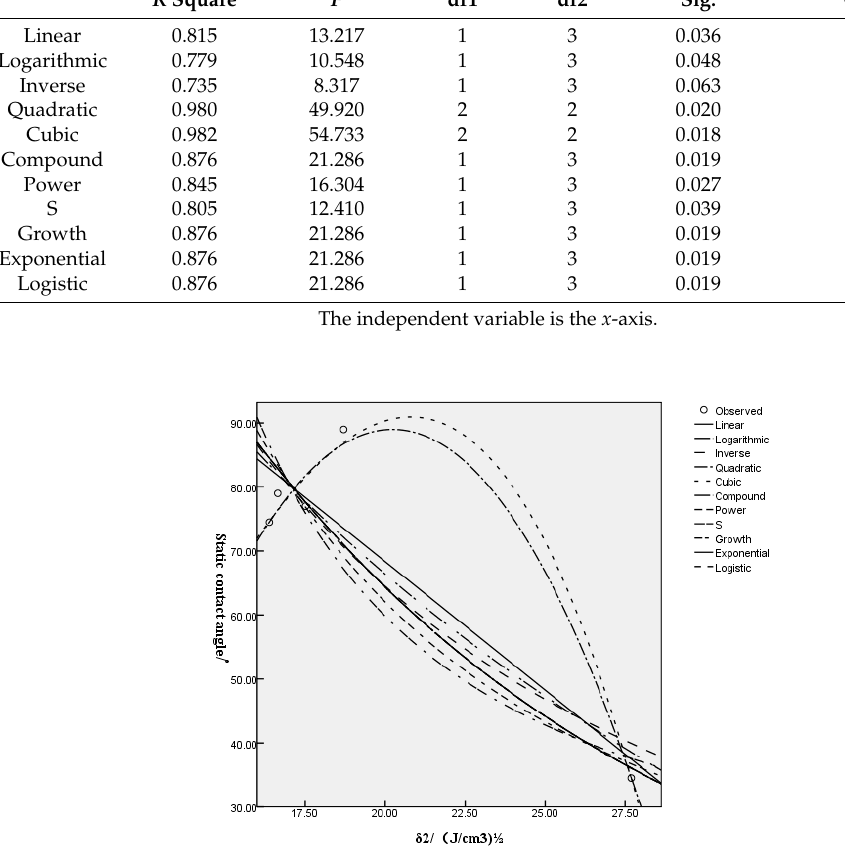
Table A5. Model summary and parameter estimates.